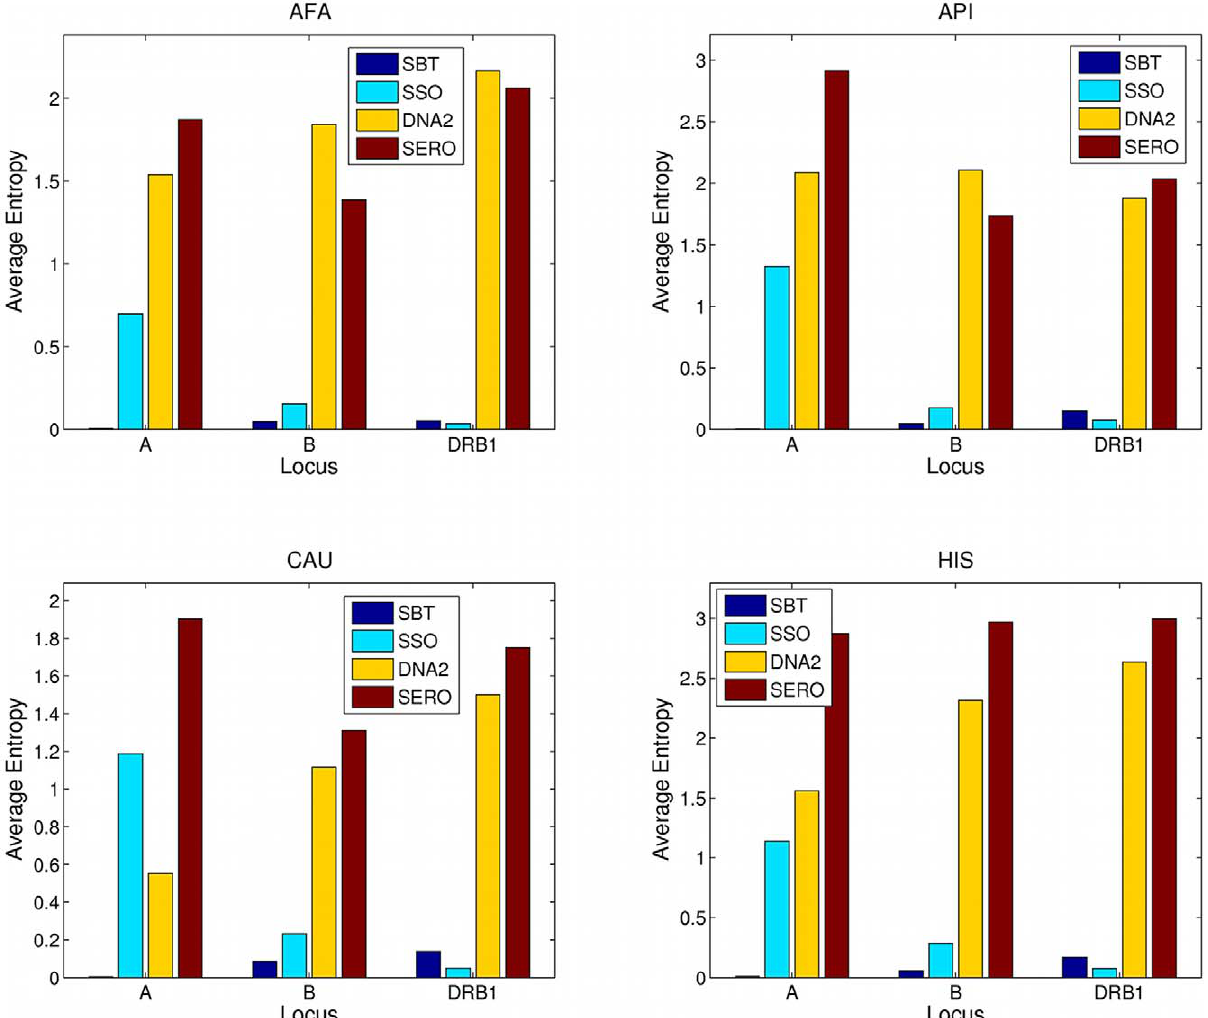
Figure 1. Average allele entropy. This figure shows locus entropies obtained for SBT, SSO, DNA2 and SERO typing formats, within each population and for three HLA loci using allele frequencies, that is, the allele entropy . The four panels correspond to four populations: AFA (African American), API (Asian-Pacific Islander), CAU (Caucasian) and HIS (Hispanic), respectively, from left to right, top to bottom. The y-axis shows entropy averaged across 1000 simulated donor typings, and the x-axis corresponds to the HLA locus that the entropy is measured for (HLA-A, HLA-B and HLA- DRB1). The color represents the typing methods used for typing: SBT (single pass sequence-based typing), SSO (sequence-specific oligonucleotides), DNA2 (two-digit allele family level DNA-based typing) and SERO (serological typing).